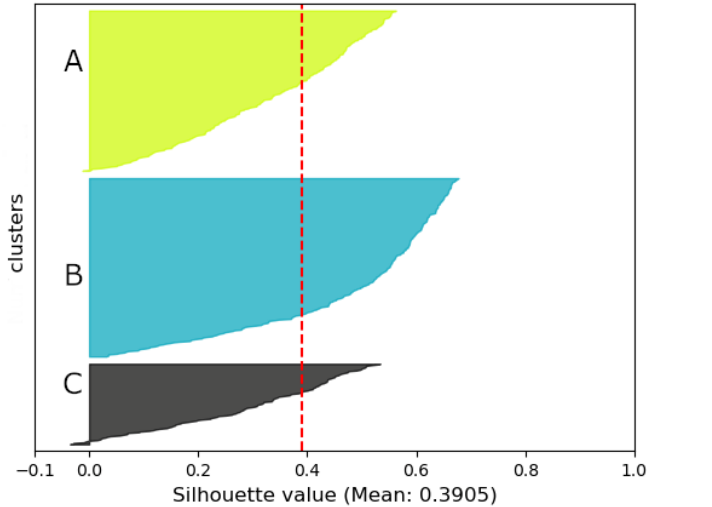
Figure 4. Silhouette graphic for case 1 showing the consistency for clusters A, B, and C.